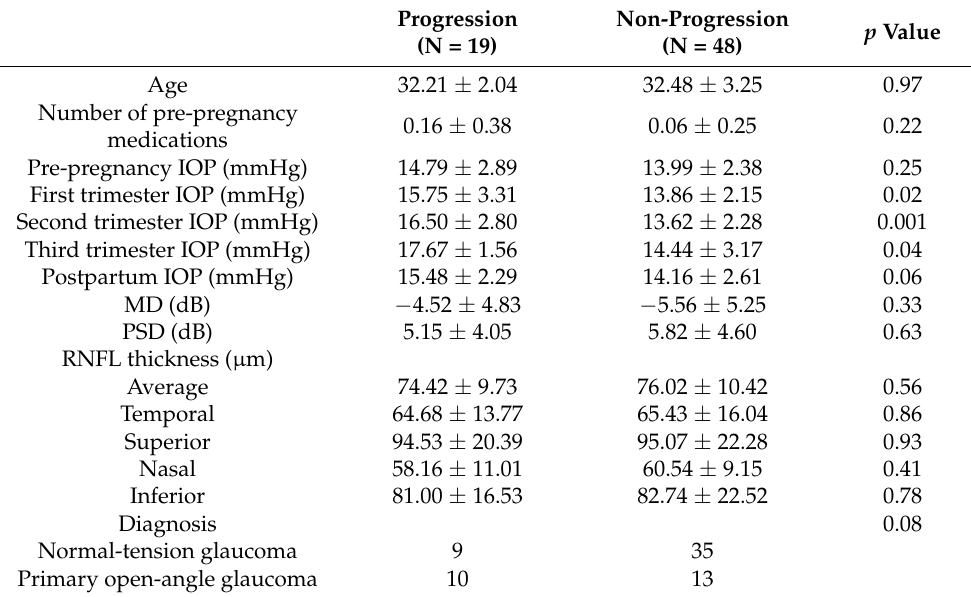
Figure 2. Kaplan–Meier cumulative survival analysis curve of glaucoma progression after pregnancy. Table 2. Comparisons of the clinical characteristics between glaucoma progression and nonpro- gression groups during pregnancy without medication.